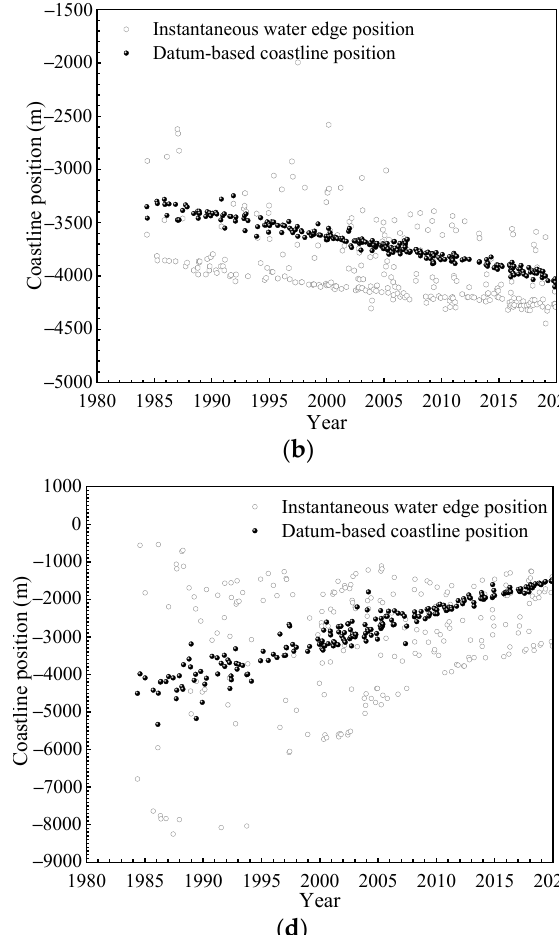
Figure 4. ( a ) The temporal changes of coastline position at the location of transect 81; ( b ) The temporal changes of coastline position at the location of transect 229; ( c ) The temporal changes of coastline position at the location of transect 331; ( d ) The temporal changes of coastline position at the location of transect 431.